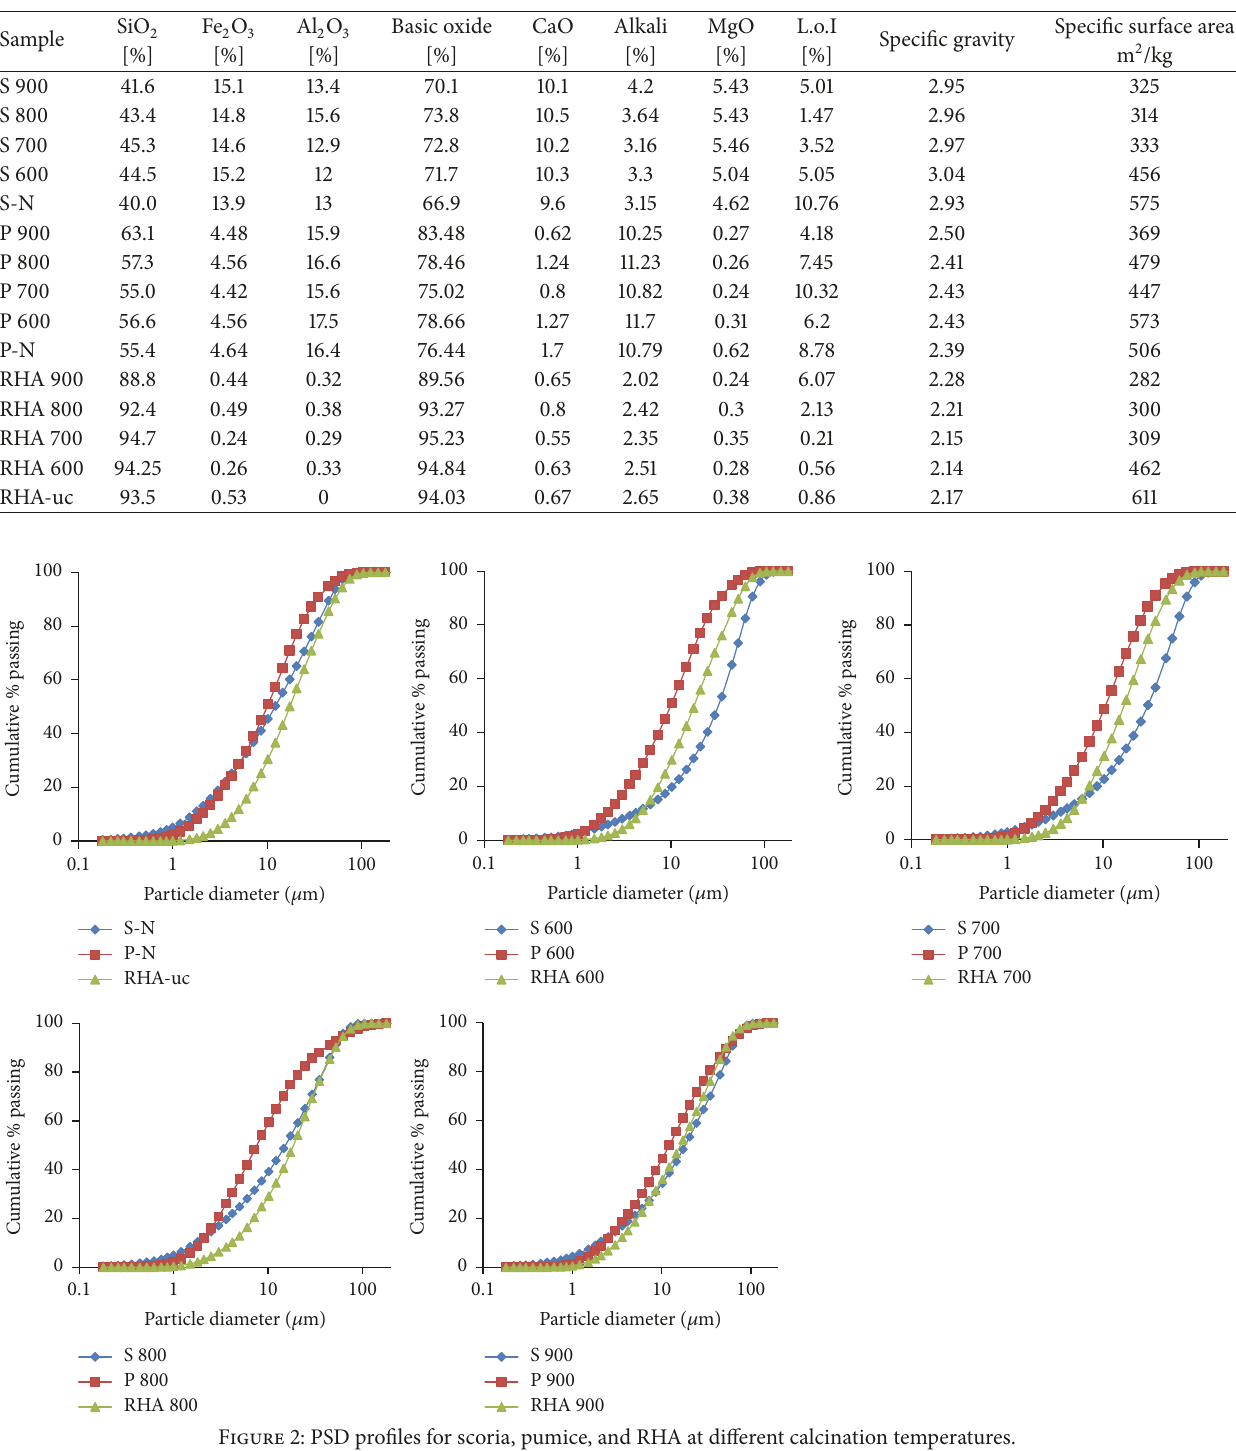
Table 3: Temperature effects on chemical composition and physical properties of the materials used.